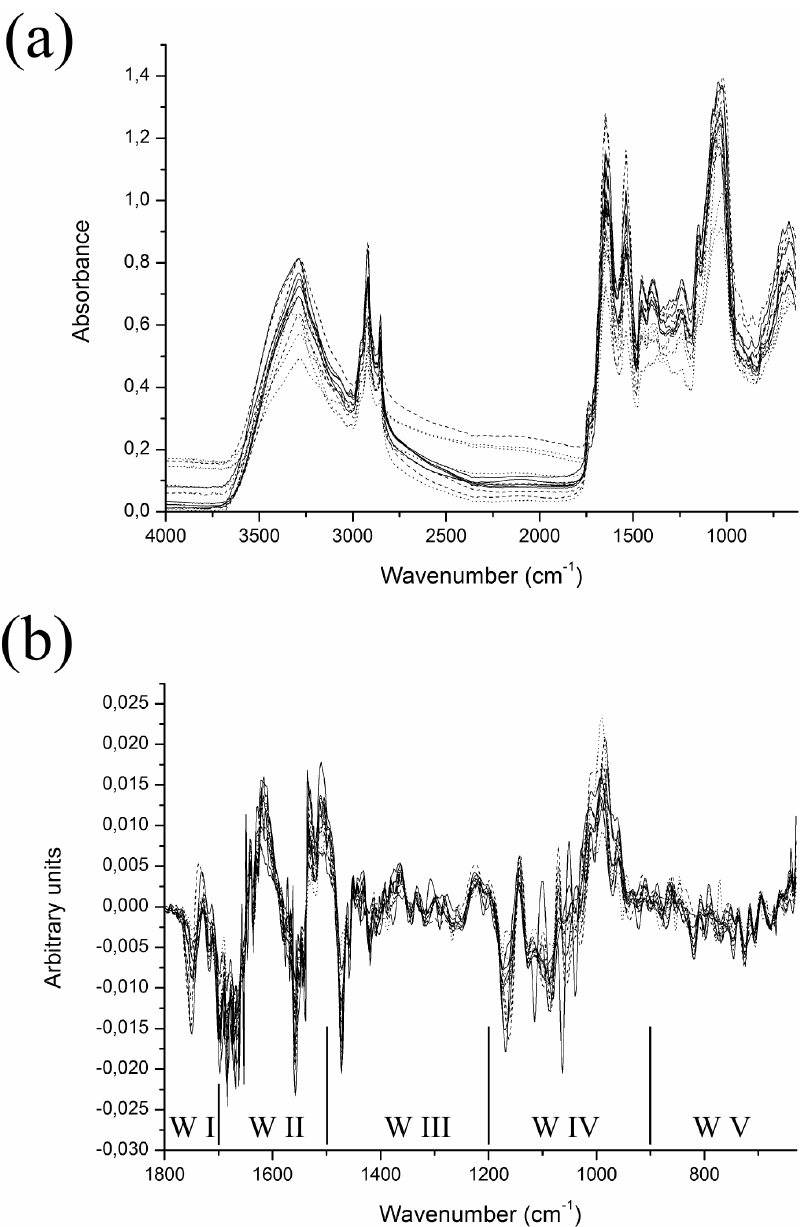
Fig. 1. Representative raw and treated spectra. (a) Raw total spectra of all strains tested, from 4000– 630 cm 2 1 and (b) enlargement of spectral region 1800–630 cm 2 1 of all strains transformed by a 9-point first derivative, with the 5 spectral windows indicated. W I: 1800–1700 cm 2 1 ; W II: 1700–1500 cm 2 1 ; W III: 1500– 1200 cm 2 1 ; W IV: 1200–900 cm 2 1 and W V: 900–675 cm 2 1